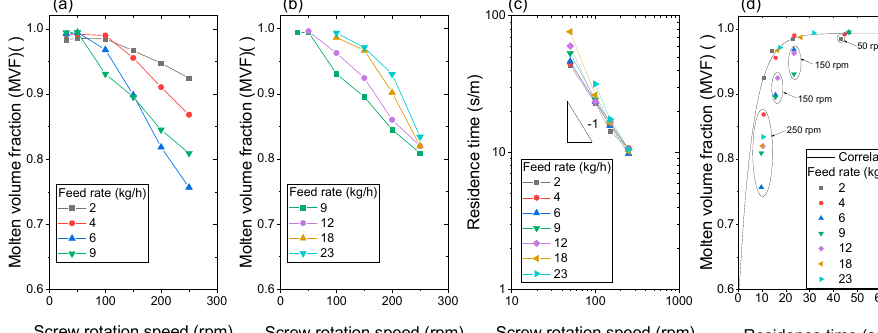
Figure 6. Effect of increase in the screw rotation speed on the molten volume fraction (MVF). The feed rate of ( a ) 2–9 kg/h, ( b ) 9–23 kg/h, and ( c ) residence time per meter of solid pellets in full-flight screws. The residence time was measured for the solid pellets at 30 °C. ( d ) Relationship between the residence time and molten volume fraction (MVF). The screw configuration was (B).